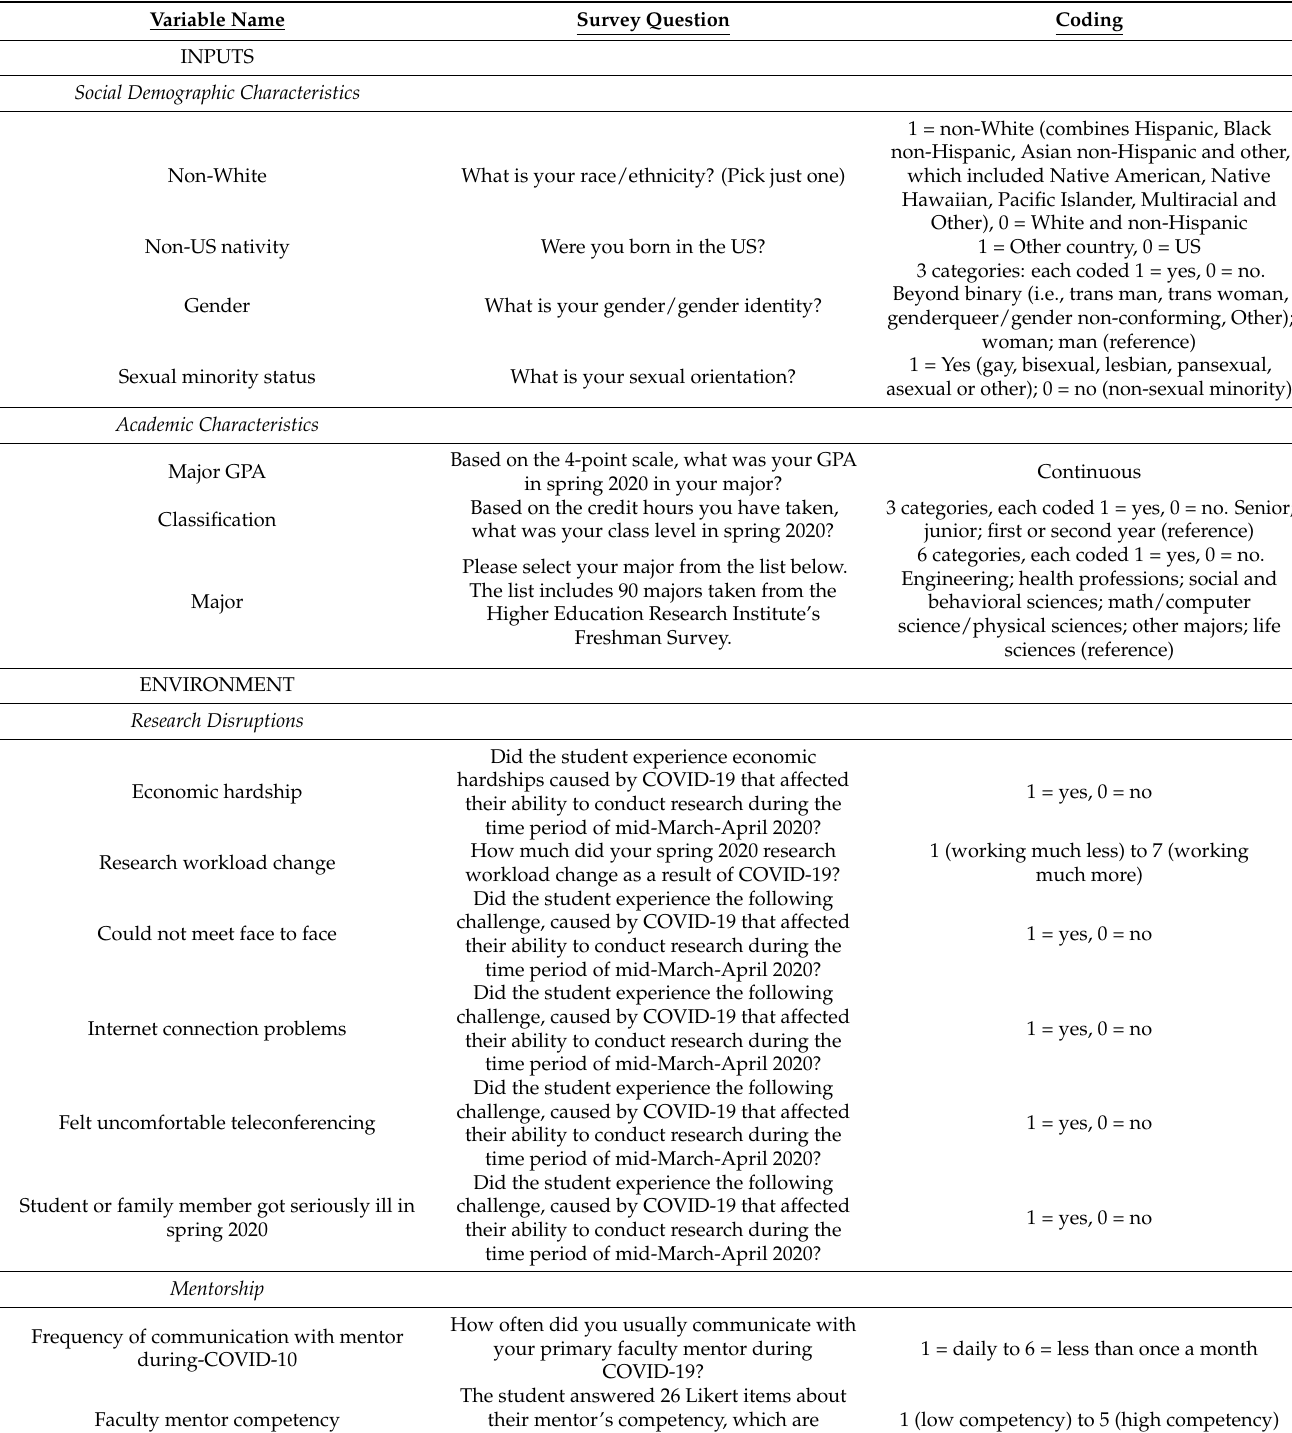
Table 1. Descriptions of input and environment variables used in the